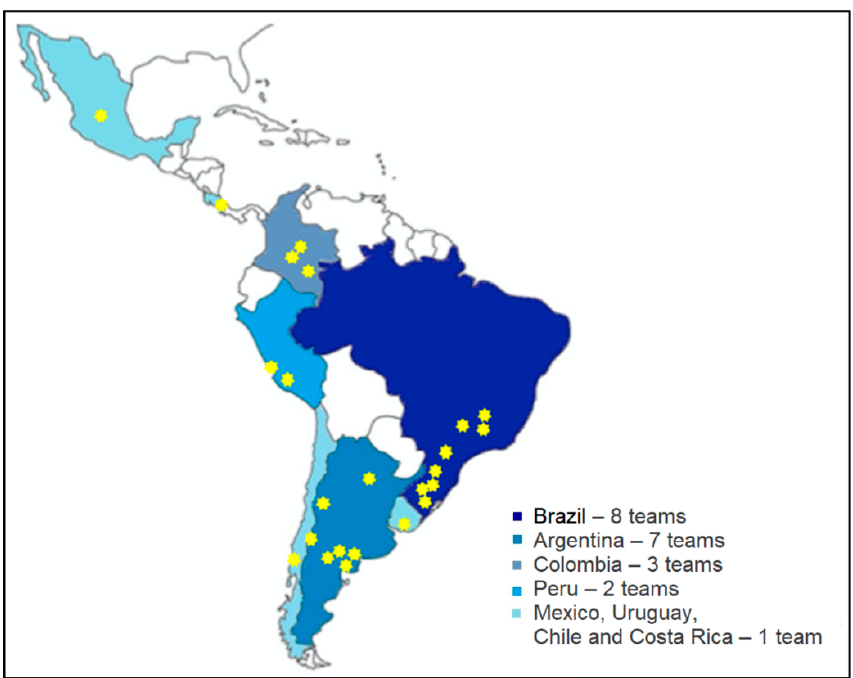
Figure 1. General information on place of work.